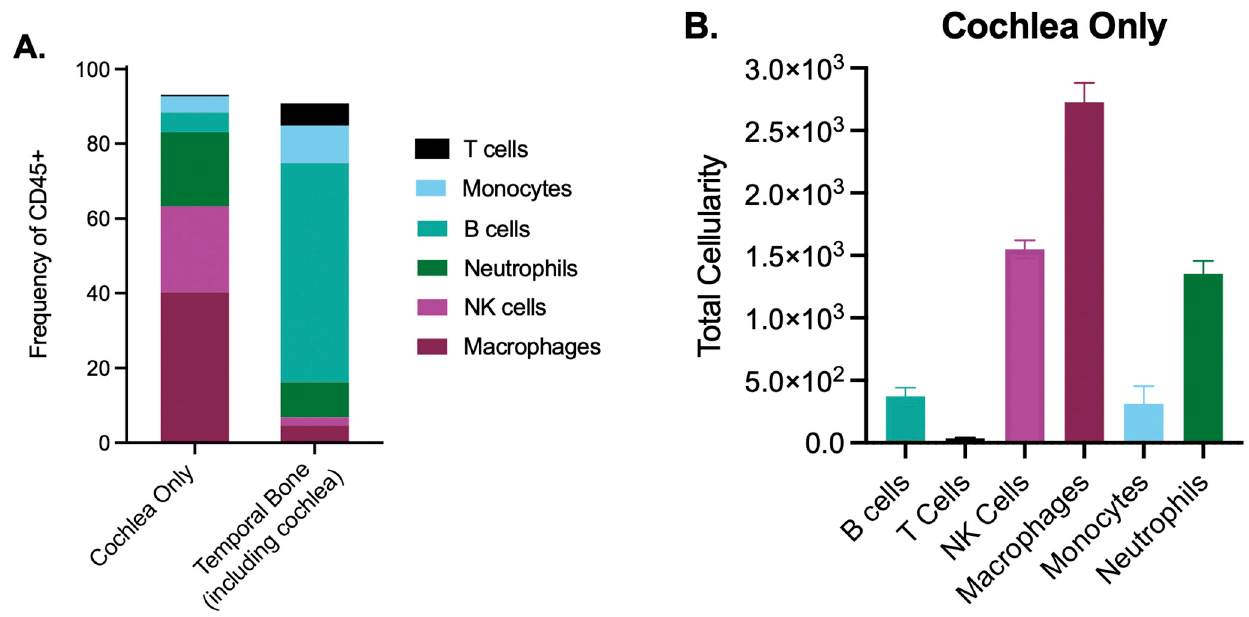
Figure 4. The developing cochlea contains a rich immune environment. Flow cytometric analysis of cochlear and temporal bone immune populations of post-natal day 10 mice. Cochlea and temporal bone were dissected as described in the methods section and similar to Jan et al. [128]. ( A ). Comparison of innate and adaptive immune populations as defined in the methods section as a percentage of CD45+ cells. ( B ). Total cellularity of innate and adaptive immune populations in the cochlea. Error bars represent the mean ± SEM. N = 5–6 mice per tissue structure.